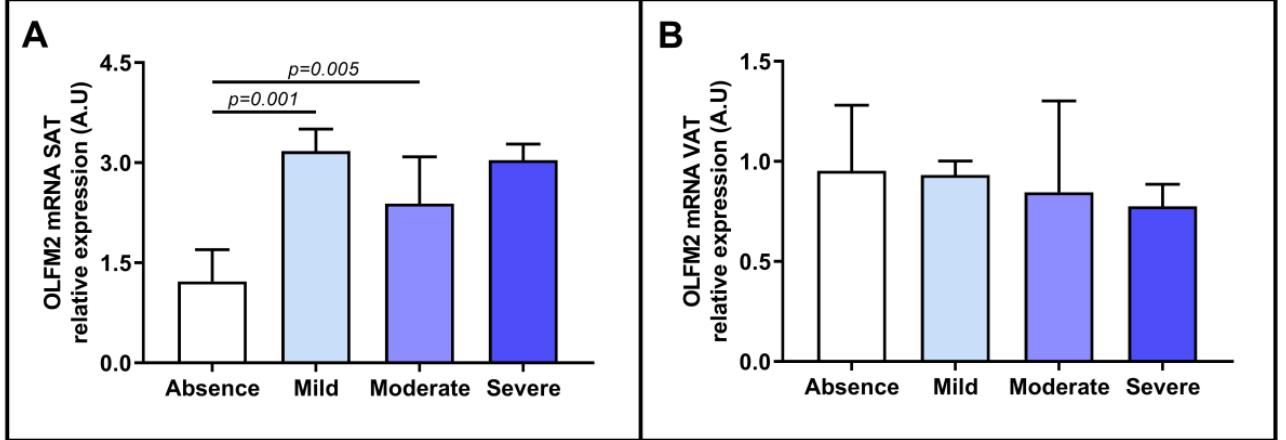
Figure 4. Comparison of mRNA abundance of OLFM2 in SAT ( A ) and in VAT ( B ) samples between subjects classified into absence, mild, moderate, and severe, according to different grades of steatosis. OLFM2, olfactomedin 2; VAT, visceral adipose tissue; SAT, subcutaneous adipose tissue; A.U arbitrary units. Mann–Whitney test was used to calculate differences between groups, and p < 0.05 was considered statistically significant.